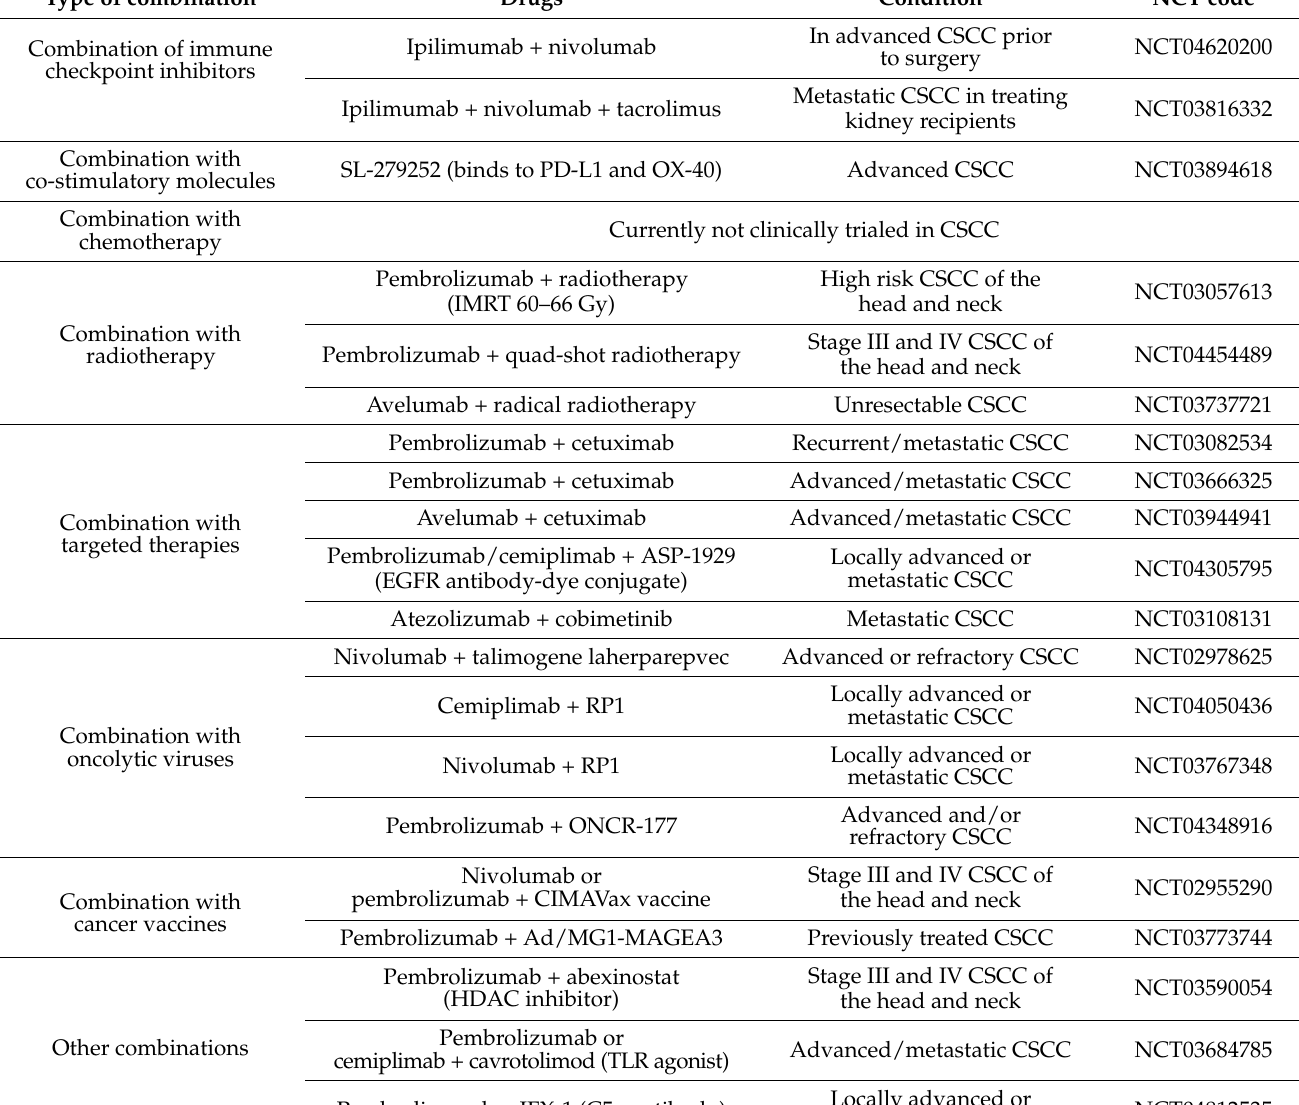
Table 3. Combination therapies to overcome resistance to immunotherapy in cutaneous squamous cell carcinoma. Type of